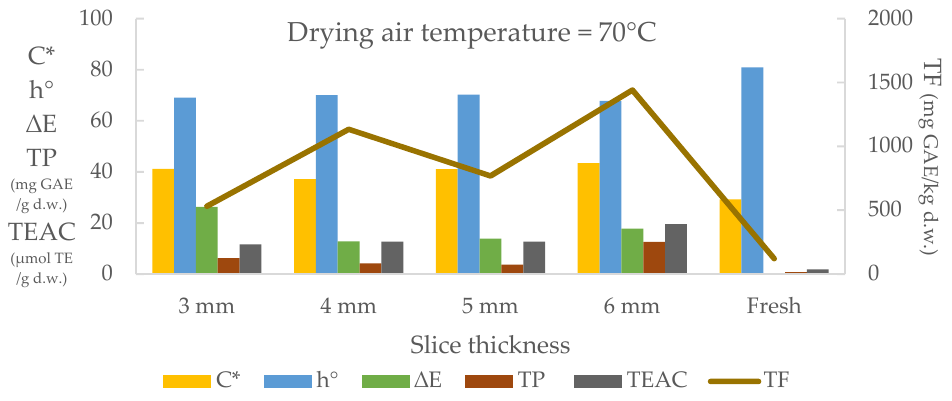
Figure 7. Effects of drying air temperature on quality parameters .